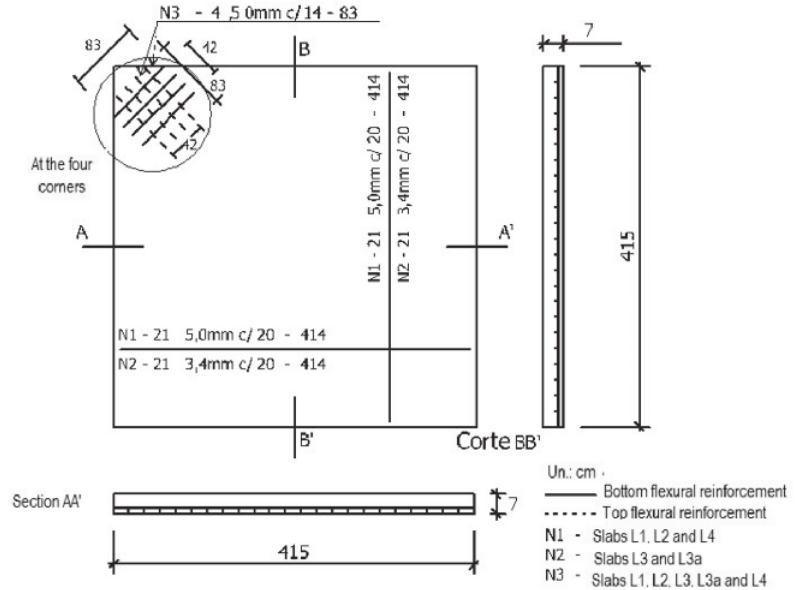
Concrete mix proportions used for slabs (kg/m³) Materials Cement(CP II F – 32)